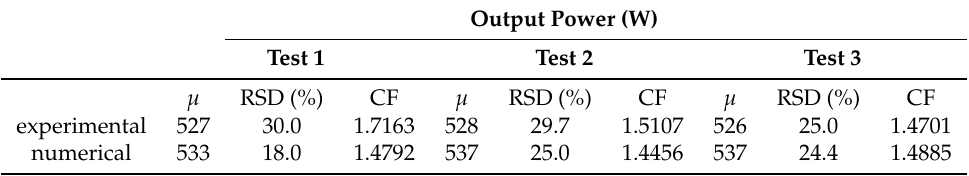
Table 4. Mean, RSD and CF of power output time series from numerical and experimental analysis.